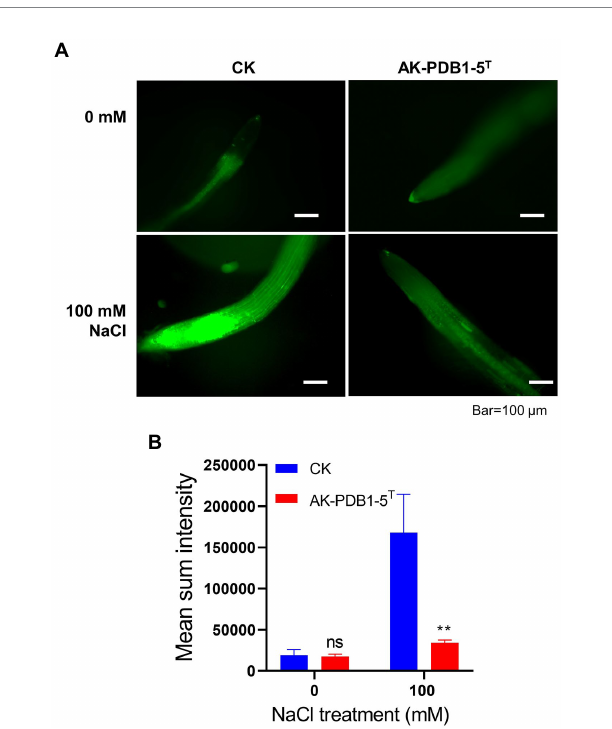
FIGURE 6 DCFH-DA staining of ROS in roots. (A) DCFH-DA straining of root tips after co-inoculation with strain AK-PDB1-5 T upon different salt conditions (0 and 100 mM NaCl). Scale bar: 100 μ m. (B) The fluorescence intensities of roots were measured by ImageJ. Error bars represent the standard error. Asterisks indicate significant differences between the control and AK-PDB1-5 T treatment under salt stress condition (100 mM NaCl, ** p <